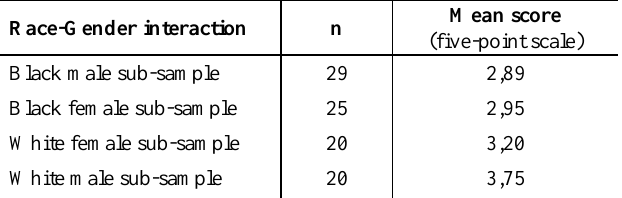
Table 6: Results of Scheffé